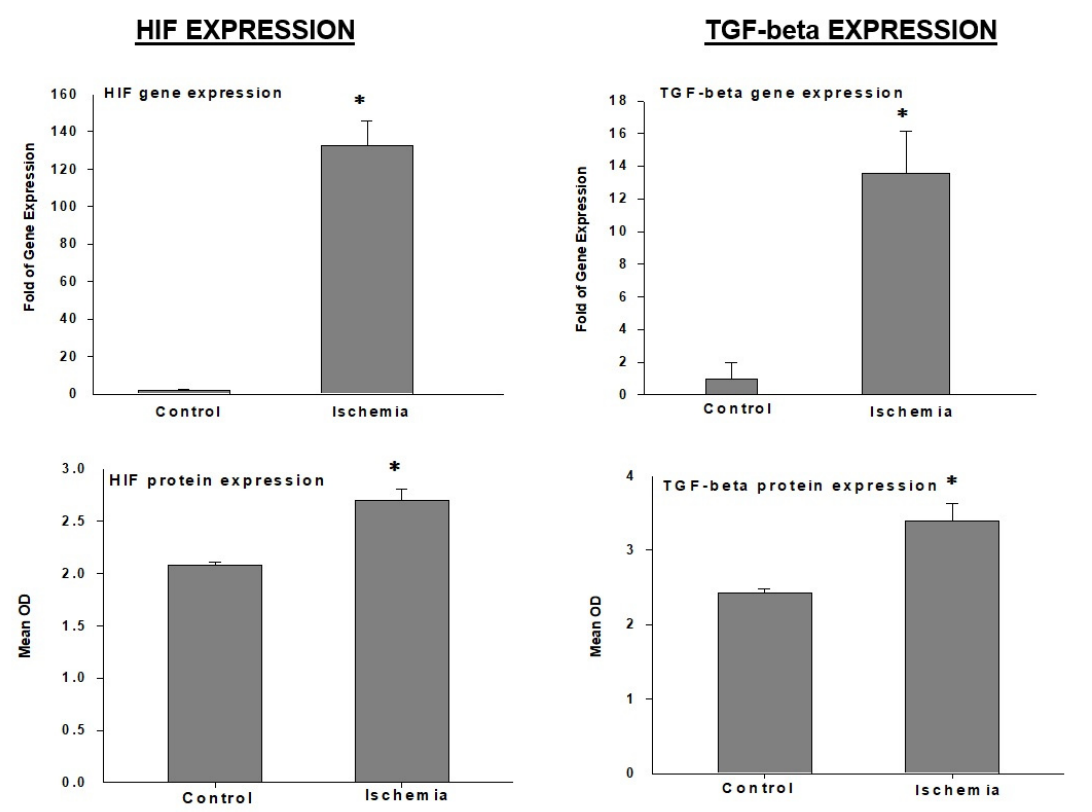
Figure 6. Expression of HIF and TGF- β in rabbit bladder tissues. * Indicates significant differences versus control. This figure is taken from our previous publication [6].